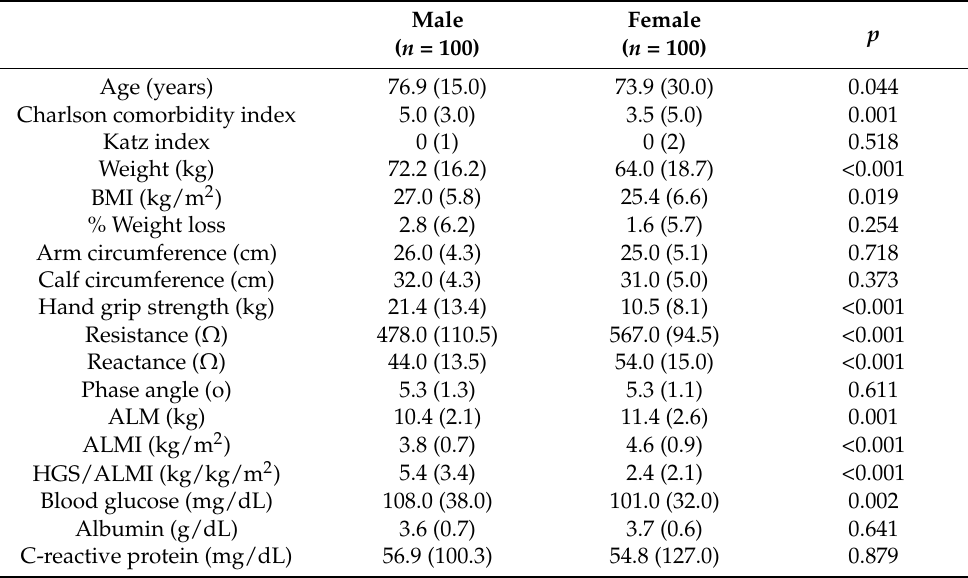
Table 1. Baseline clinical characteristics, blood samples data and body composition data of the included patients at admission according to